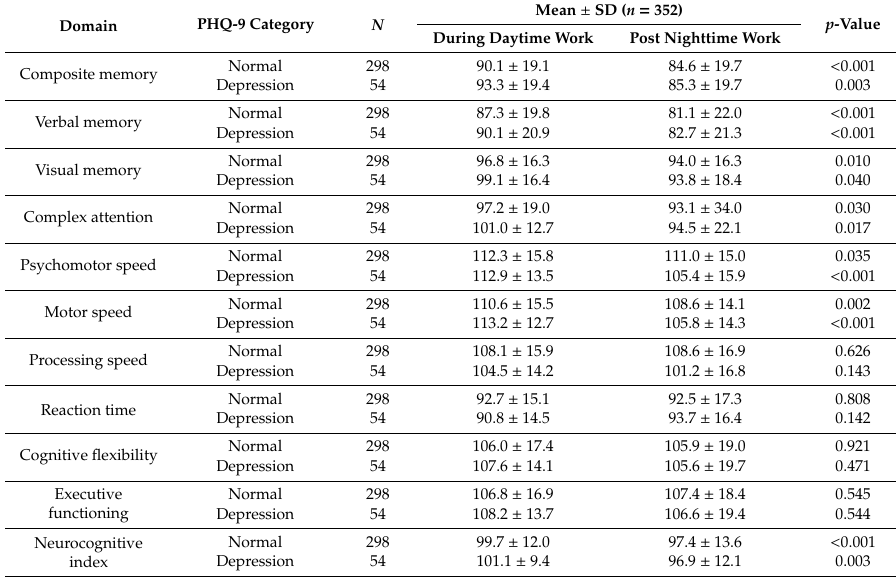
Table 4. Comparison of the neurocognitive function during the daytime work and after the night shift work of firefighters according to the Patient Health Questionnaire-9 (PHQ-9)